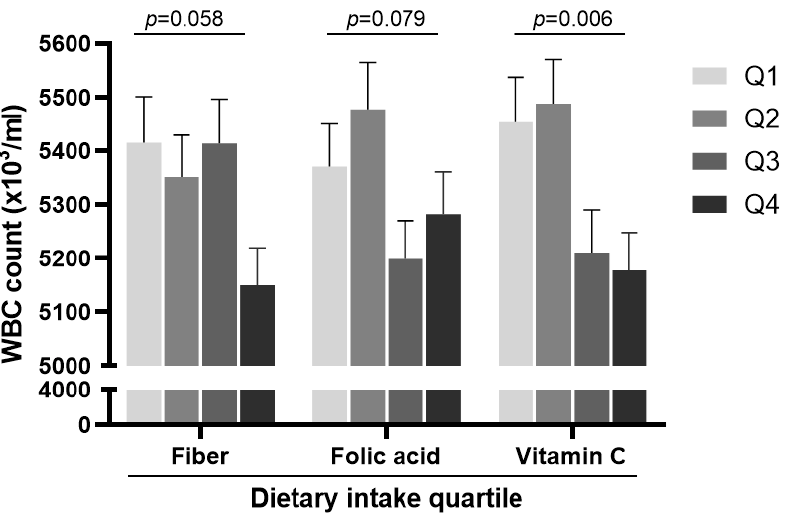
Figure 4. WBC counts in the different nutrient intake quartiles at the 5-year follow up. WBC, white blood blood cells.